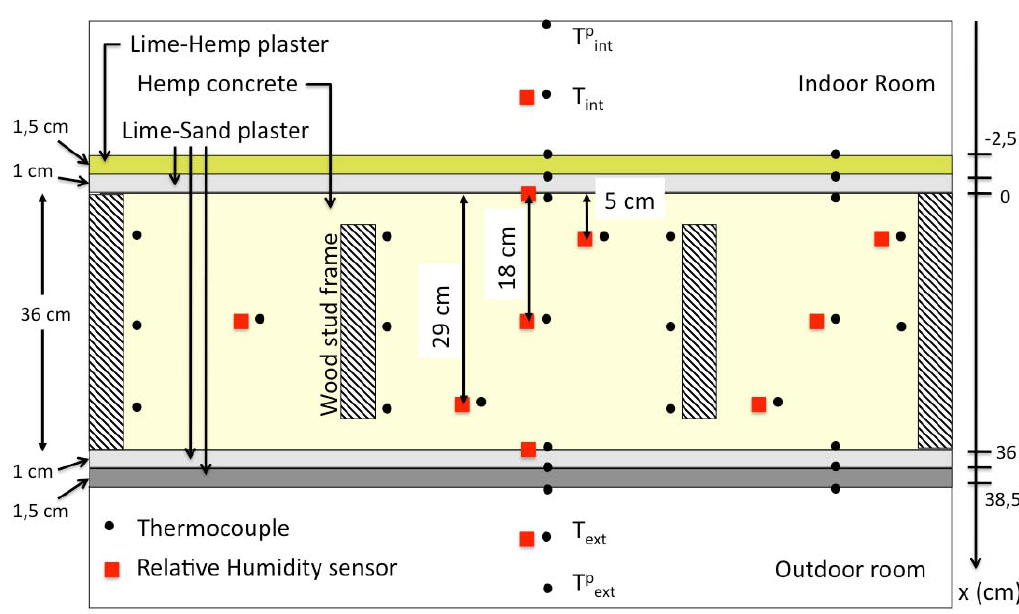
Figure 3. Localisation of temperature and relative humidity sensors within the coated hemp concrete